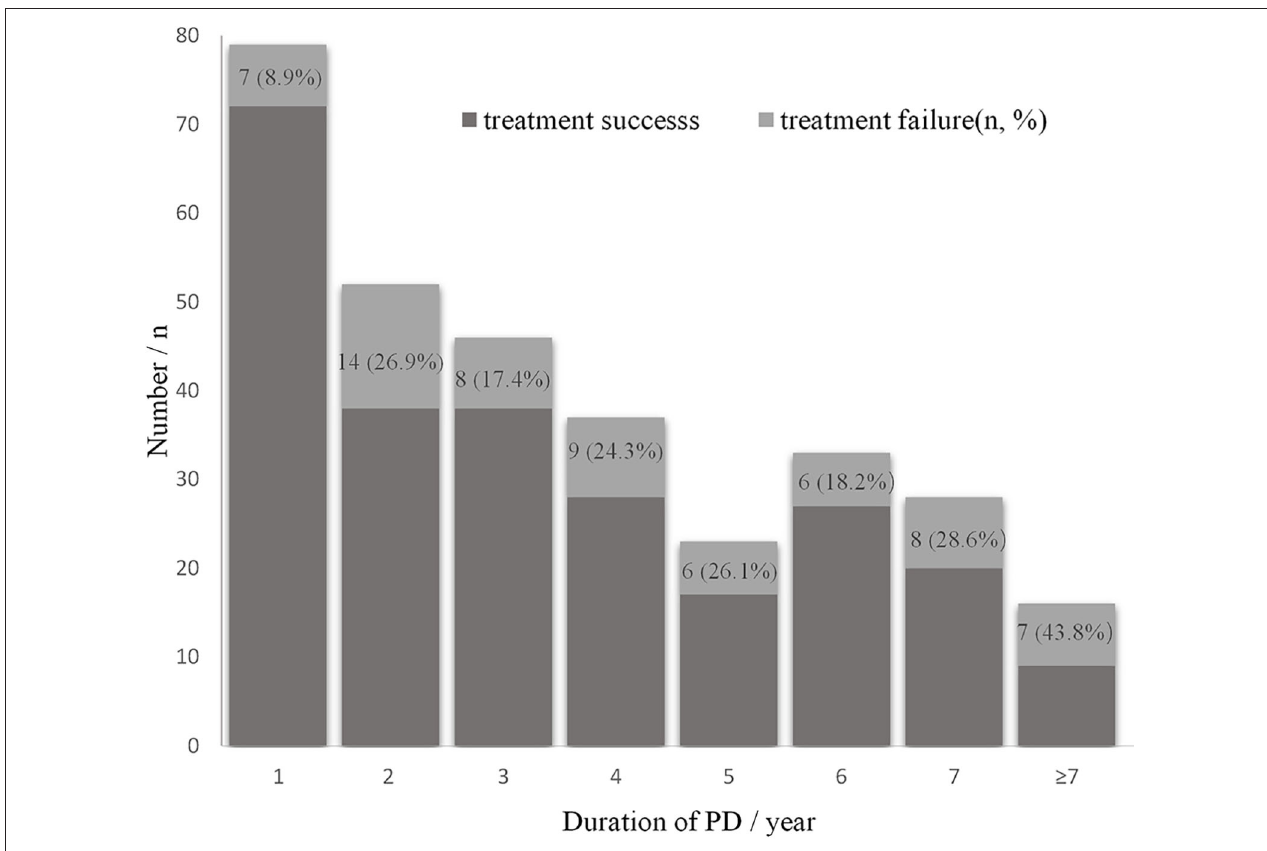
FIGURE 2 | Distribution of treatment outcomes by peritoneal dialysis